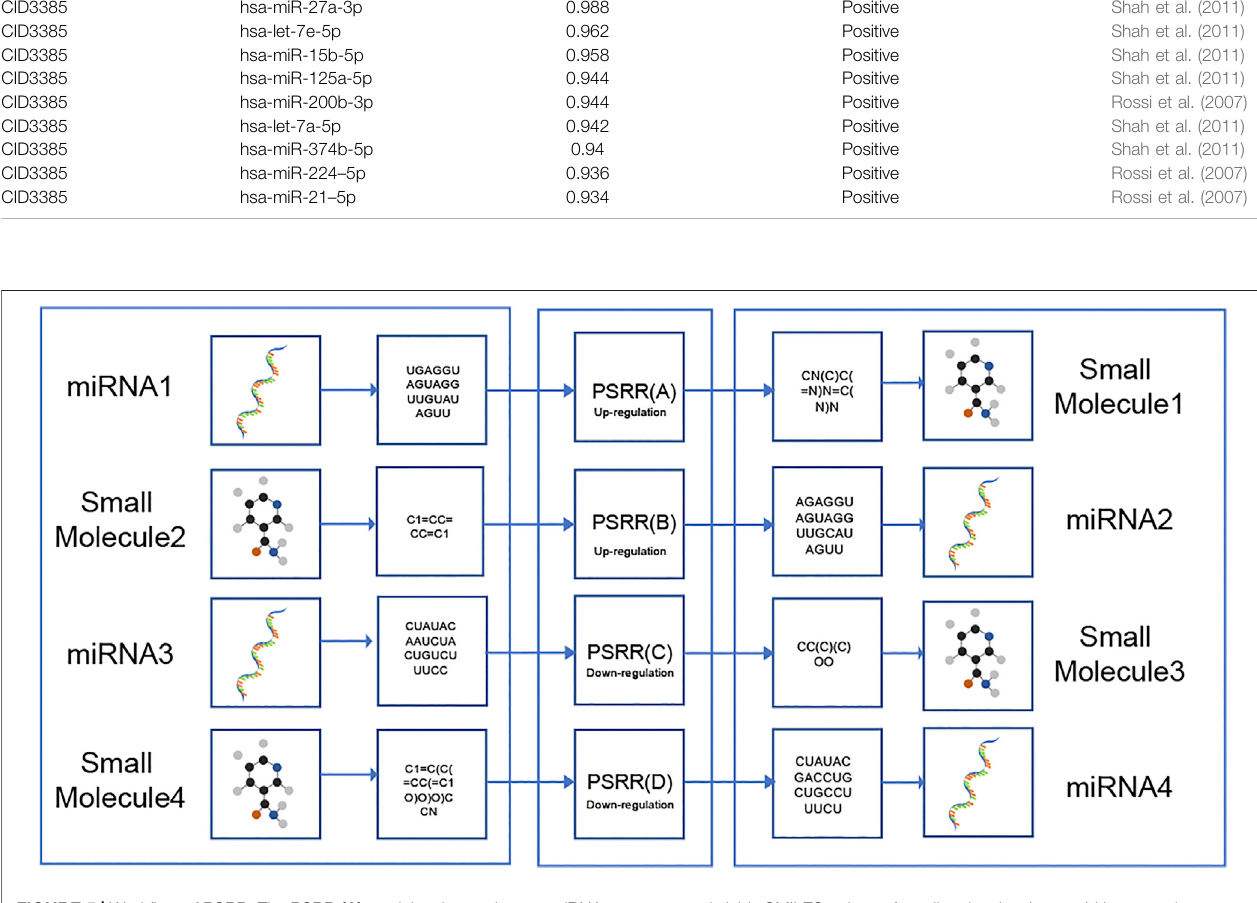
Table S2 ) and 9 out of 10 up-regulation pairs ( Supplementary Table S3 ), which suggested that the accuracy values of down- regulation and up-regulation models were 0.91 and 0.90 in the independent dataset.